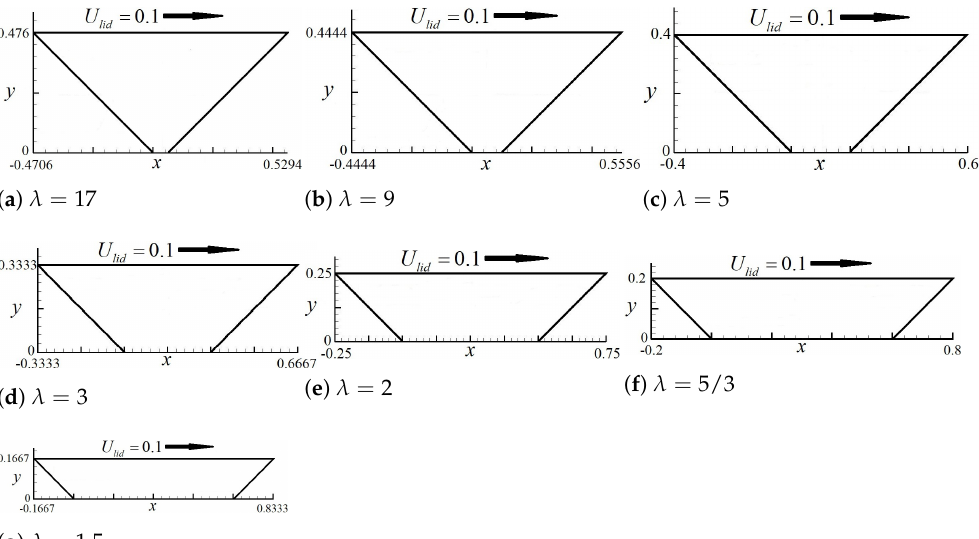
Figure 5. Different geometries of right-angled isosceles trapezoidal cavity with the long topline driven.